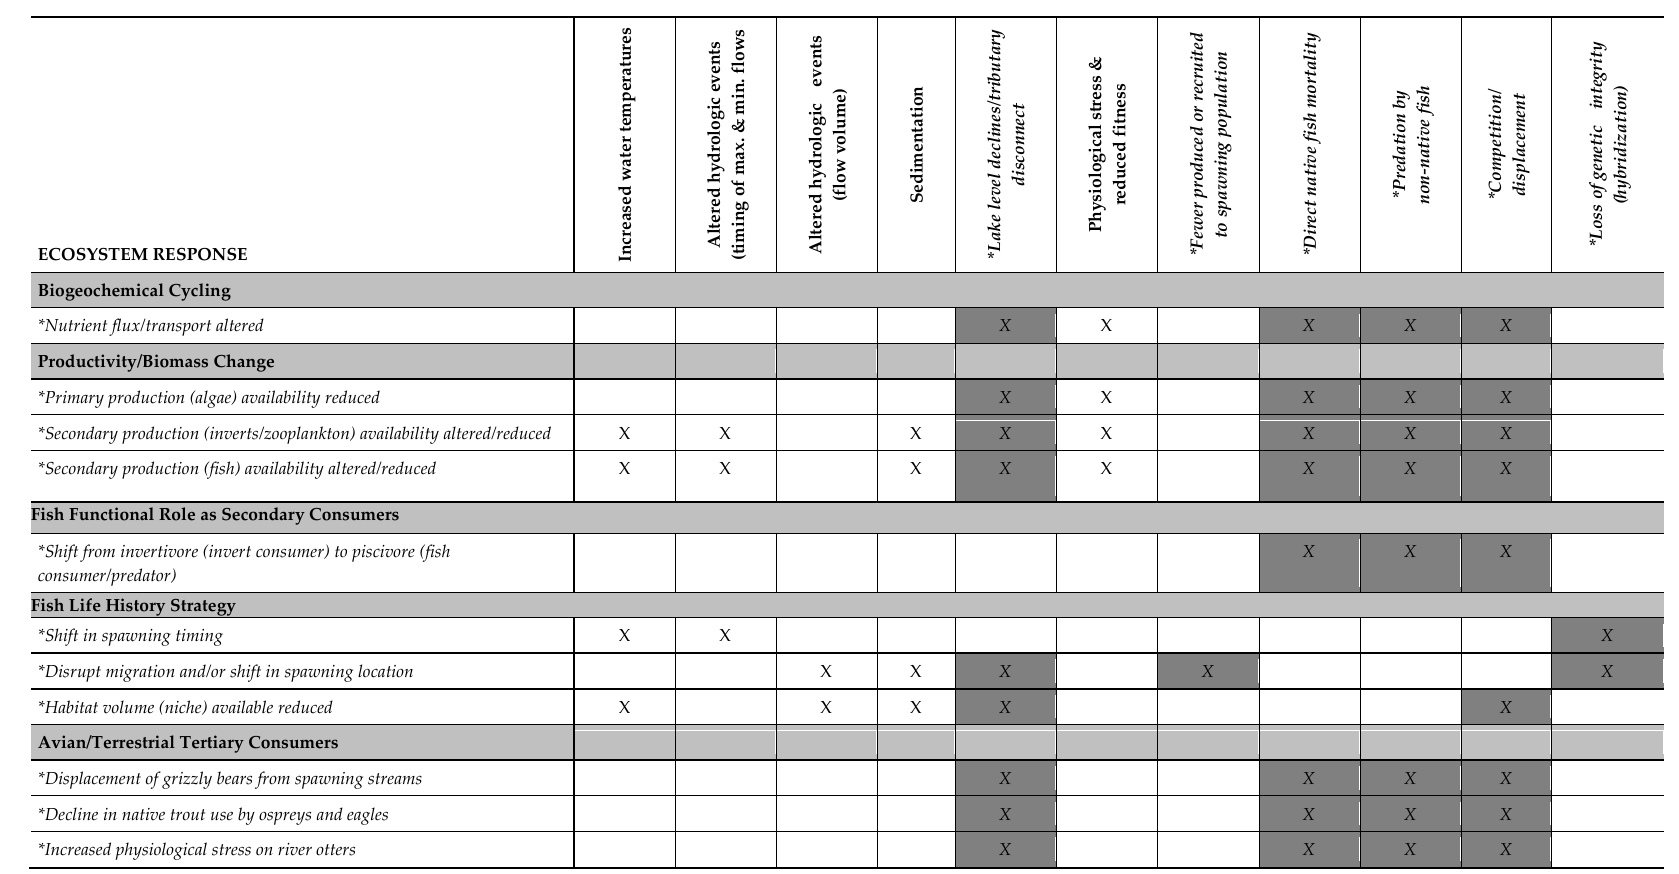
Table A3. Cont. Fishes 2020 , 4 , x FOR PEER REVIEW 40 of